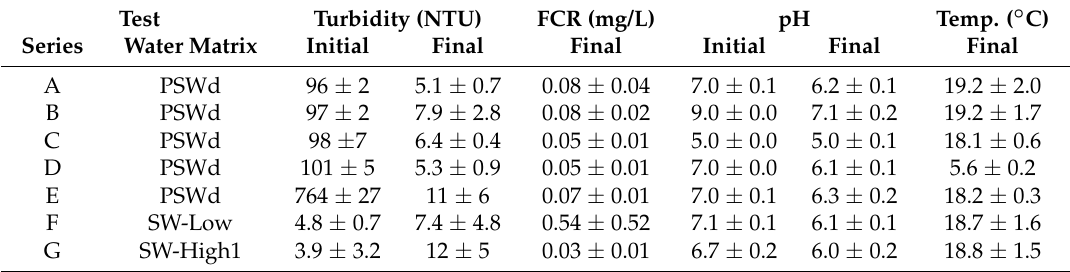
Table 3. Summary of AQS treatment performance trials mean physico-chemical results (with ± standard deviations) for initial (untreated) and final (after CDP treatment—60 min for all test conditions except “cold temperature” series D in which treatment time totaled 20 min)